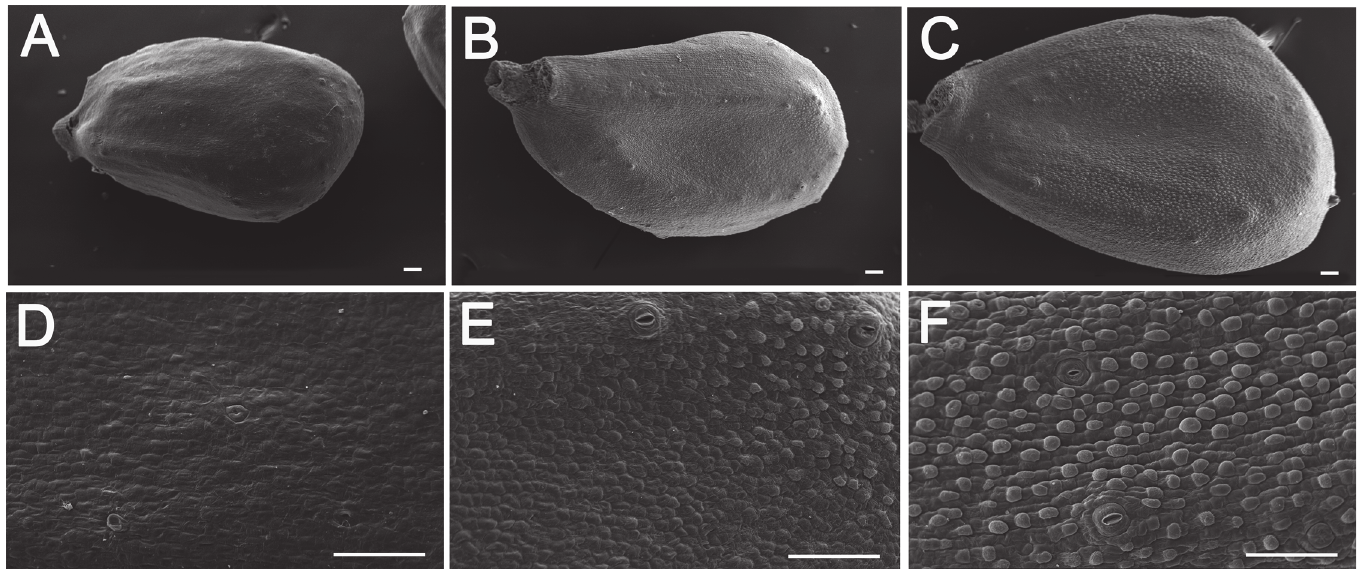
Fig 1. Fiber initiation of G . hirsutum grown in planta . Scanning microscopic images of G . hirsutum TM-1 unfertilized ovules (top panel) and epidermal tissue (bottom panel) were photographed from field-grown ovules that were harvested at 0900 on -1 DPA (A & D) and 1700 on -1 DPA (B & E), and 0800 on 0 DPA (C & F). Scale bars equal 50 μ